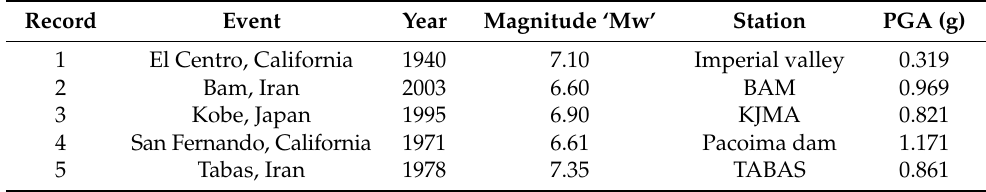
Table 1. Ground motion details